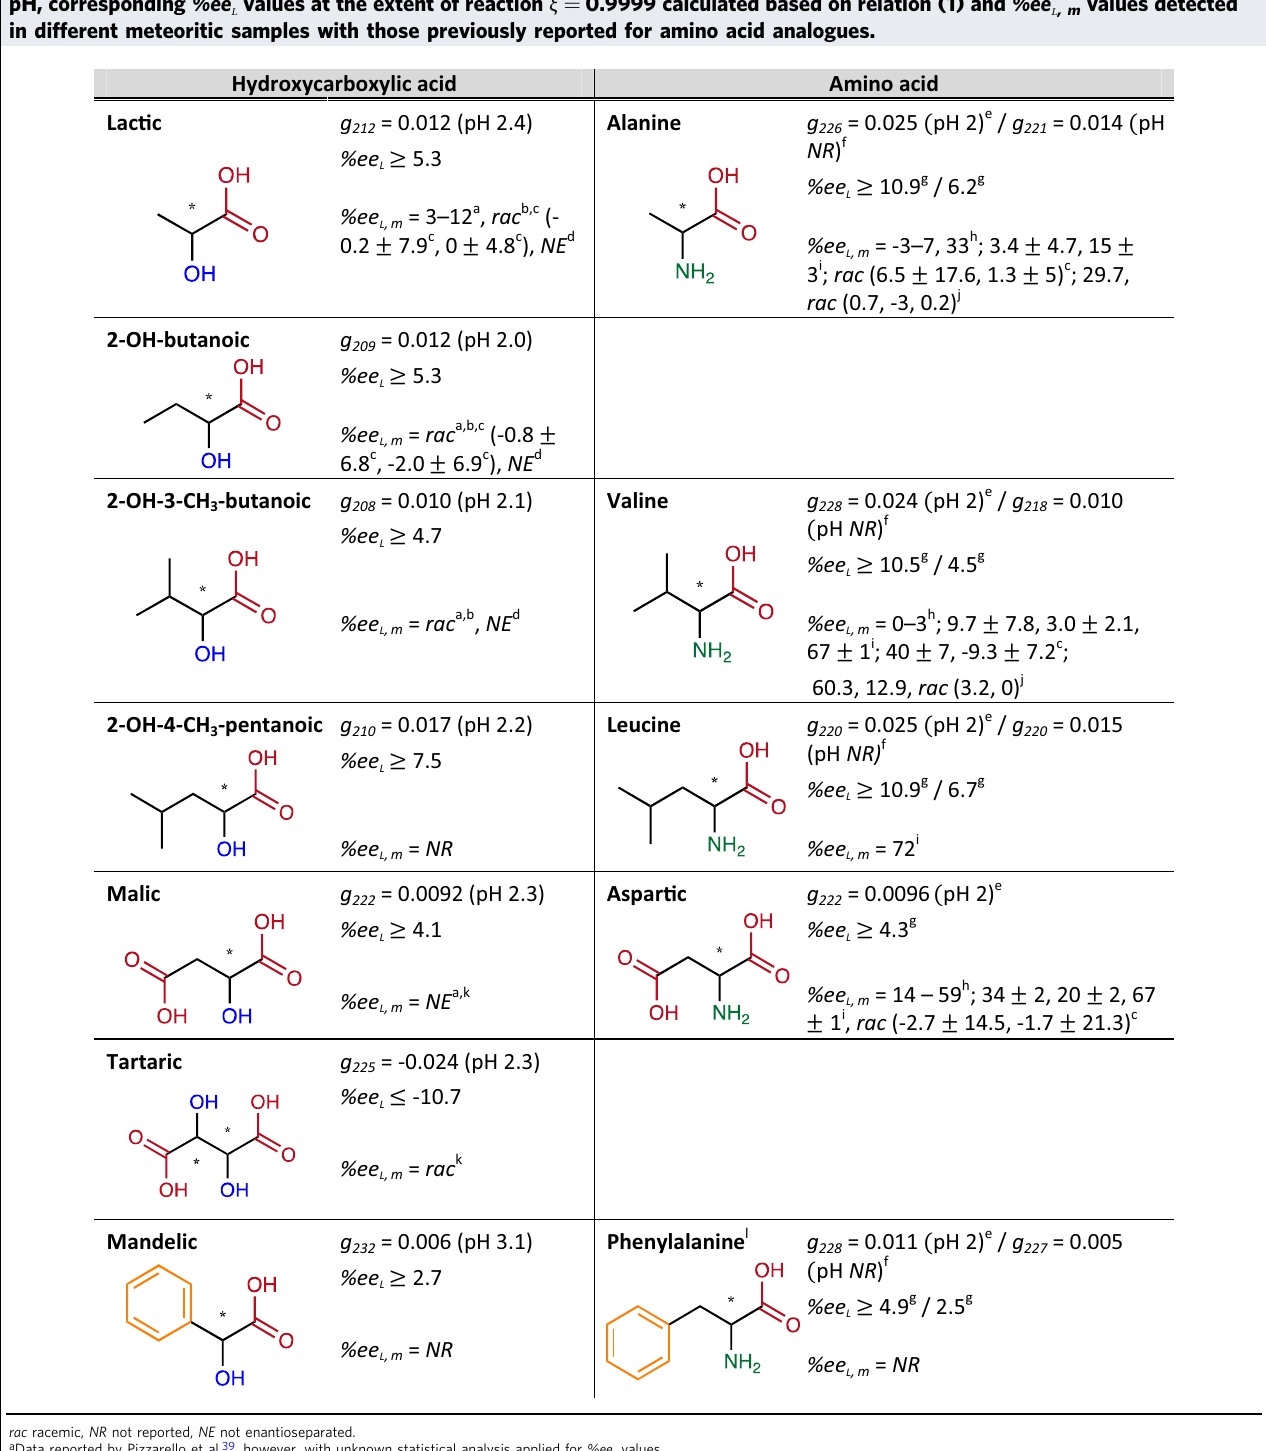
values detected L , m